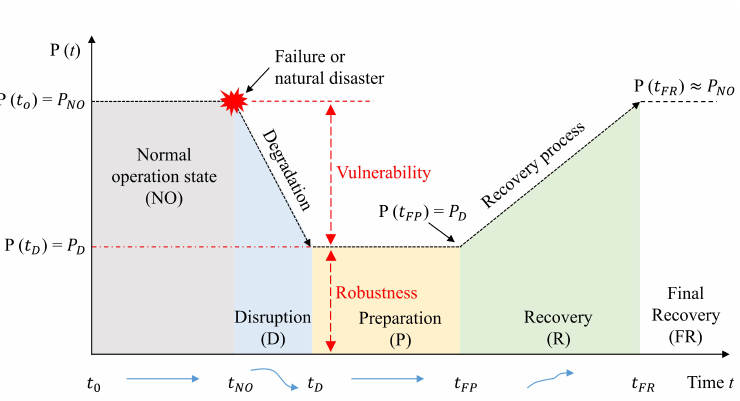
Figure 1. Power system behaviour during failures or natural disasters (representation adapted from